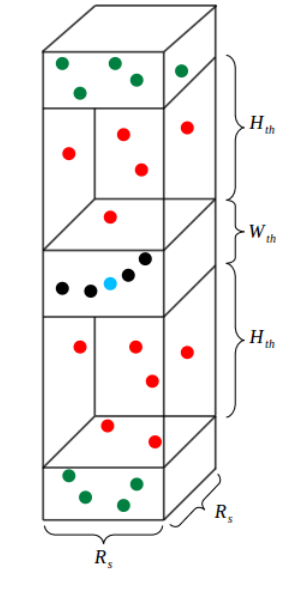
Figure 1. Graphic representation of the criteria to label a point as power line